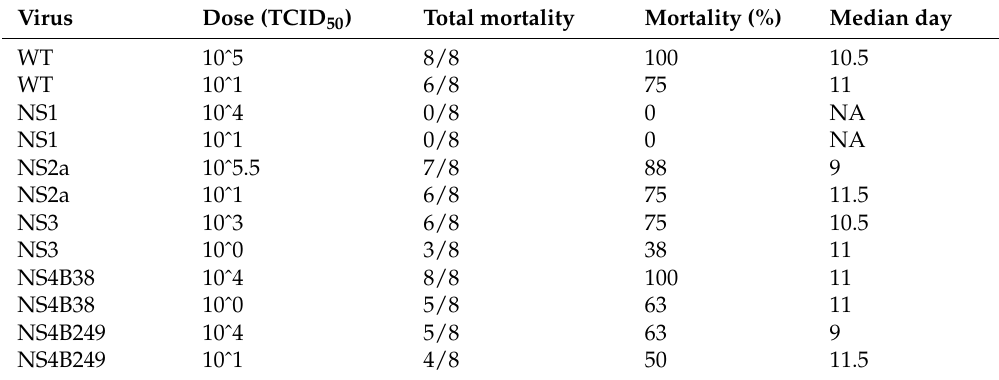
Table 3. Mortality data of six-week-old female C57BL/6 mice inoculated i.p. with high and low doses of the WT and mutant lineage 2 WNVs. Virus Dose (TCID 50 ) Total mortality Mortality (%) Median day WT 10ˆ5 8/8